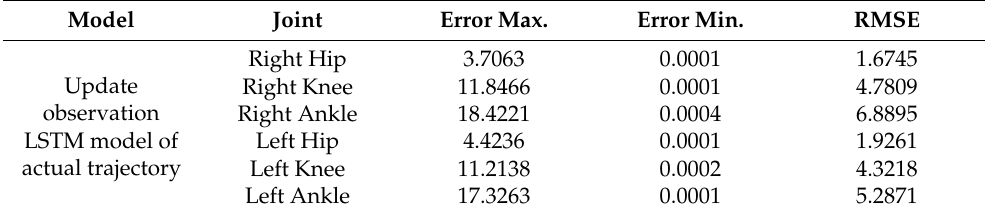
Table 2. The prediction result of actual trajectory with wearable joint angle measurement device. Model Joint Error Max. Error